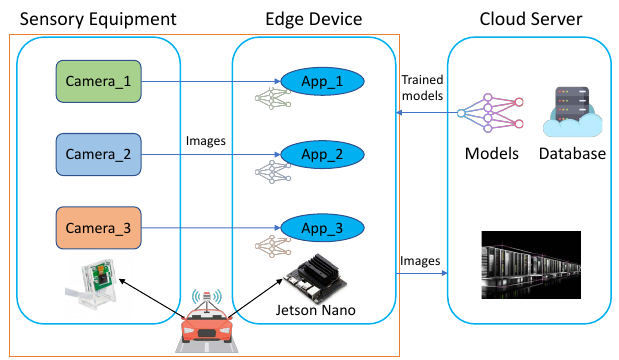
Figure 1. The architecture of the multi-model-based object detection system for autonomous